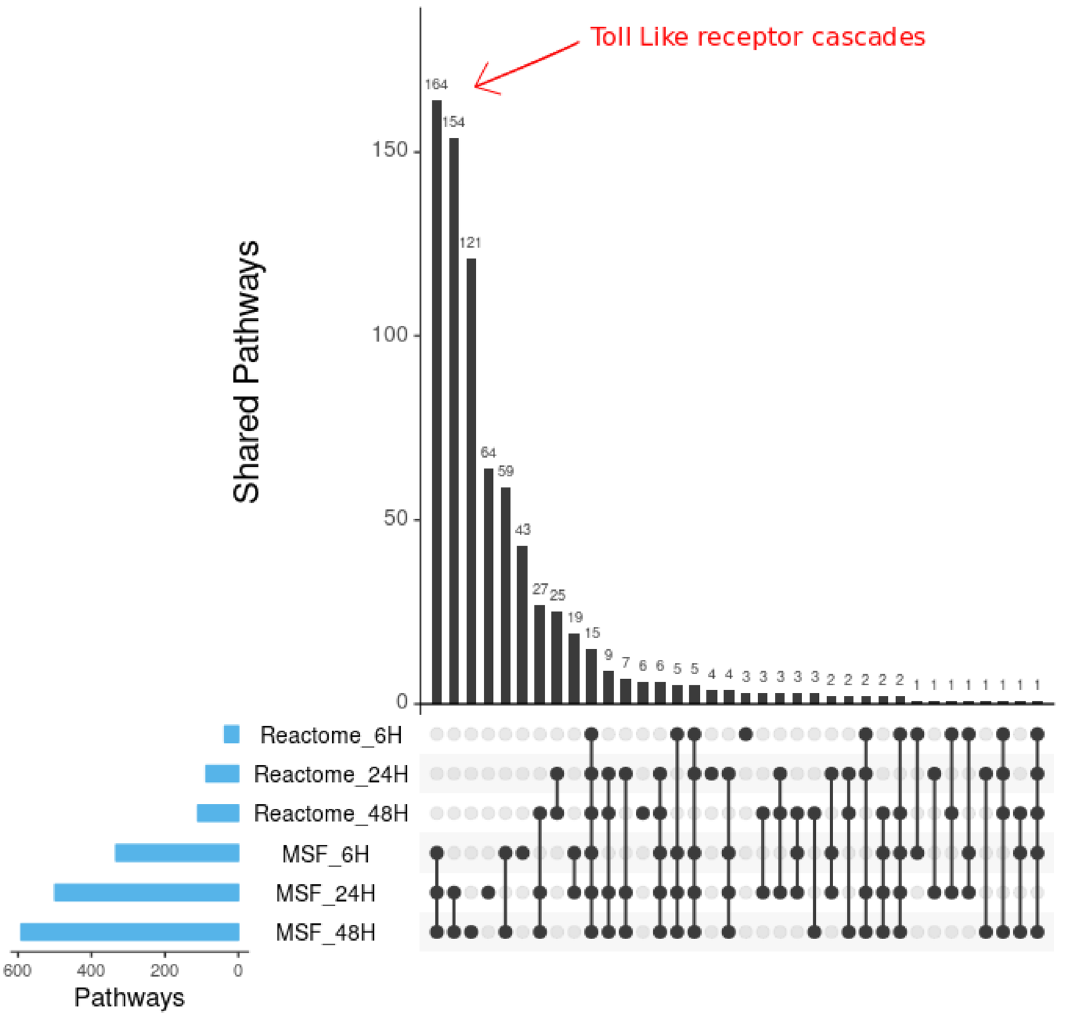
Figure 5. The Upset plot shows the number of shared pathways between MSF identified sub-graph gene list and DEG cut-off list for the three time-points. All 10 different Toll-like receptor cascades are in the set of 164 shared pathways only between MSF at different